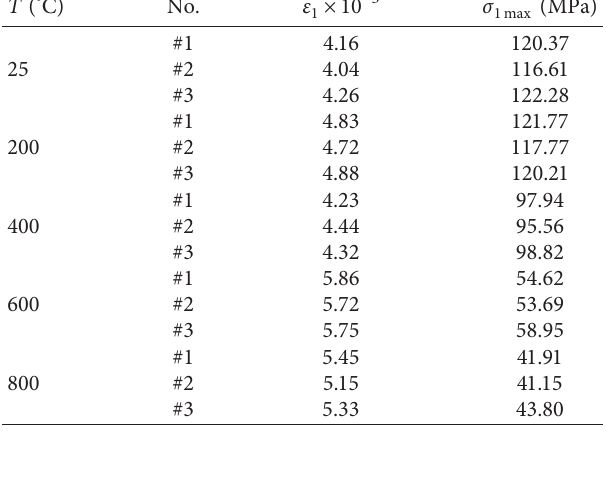
Table 2: Test data.